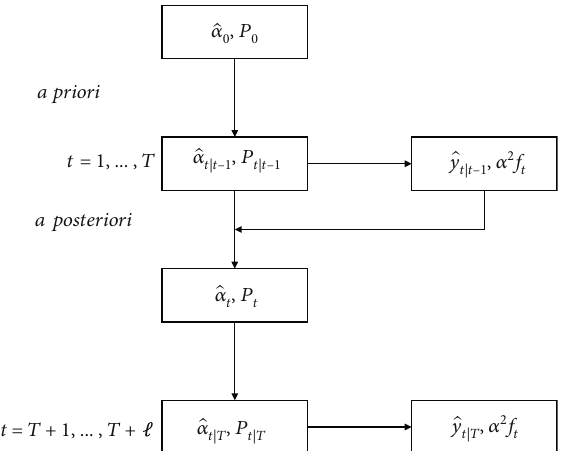
Figure 1: Flowchart Kalman fi lter. It is a real-time algorithm that can accurately estimate observable and unobservable parameters as a recursive estimator. The estimated state from the previous time step and the current measurement is required for the current state estimation. Compared to batch estimating approaches, there is no requirement for a historical record of observations and evaluations. Precision predictions are made possible by the use of high-accuracy